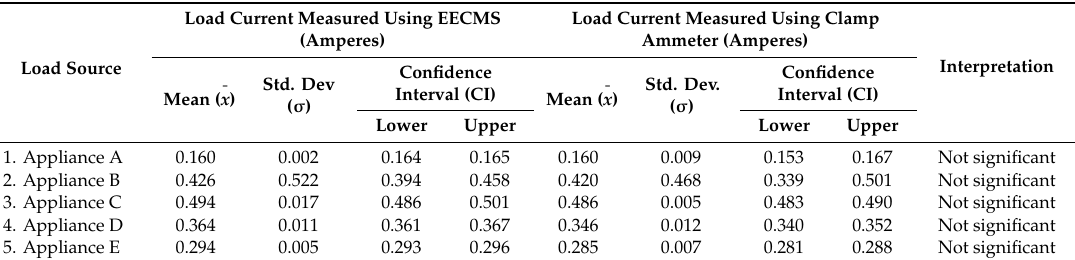
Table 5. Descriptive statistical representation of the electric current measured using the